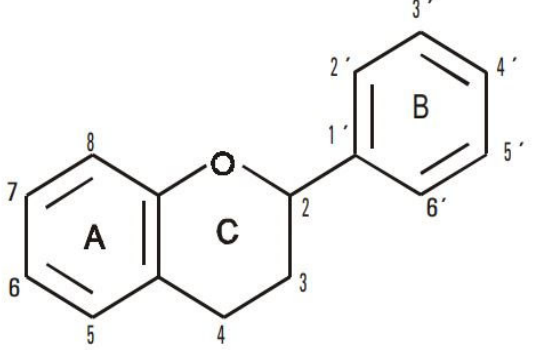
Figure 6. Basic structure of flavonoids showing the A and B rings, which are responsible for the prooxidant activity. Source: [42] . prooxidant activity. Source: